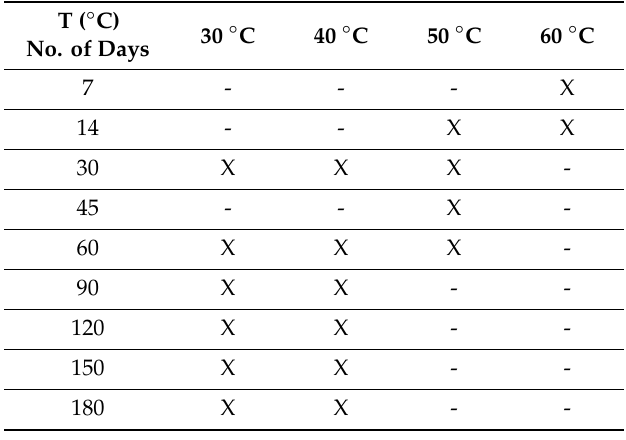
Table 2. Film-coated tablet stability study protocol. Each formulation, polyethylene glycol (PEG) to saxagliptin (SAXA) = 0.8, 1.0, 1.2, and 1.4, was exposed to four di ff erent temperature (T) conditions (30–60 ◦ C) and three di ff erent nominal relative humidity (RH) conditions (10%, 30%, and 50%) for a prescribed number of days. X represents a sampling